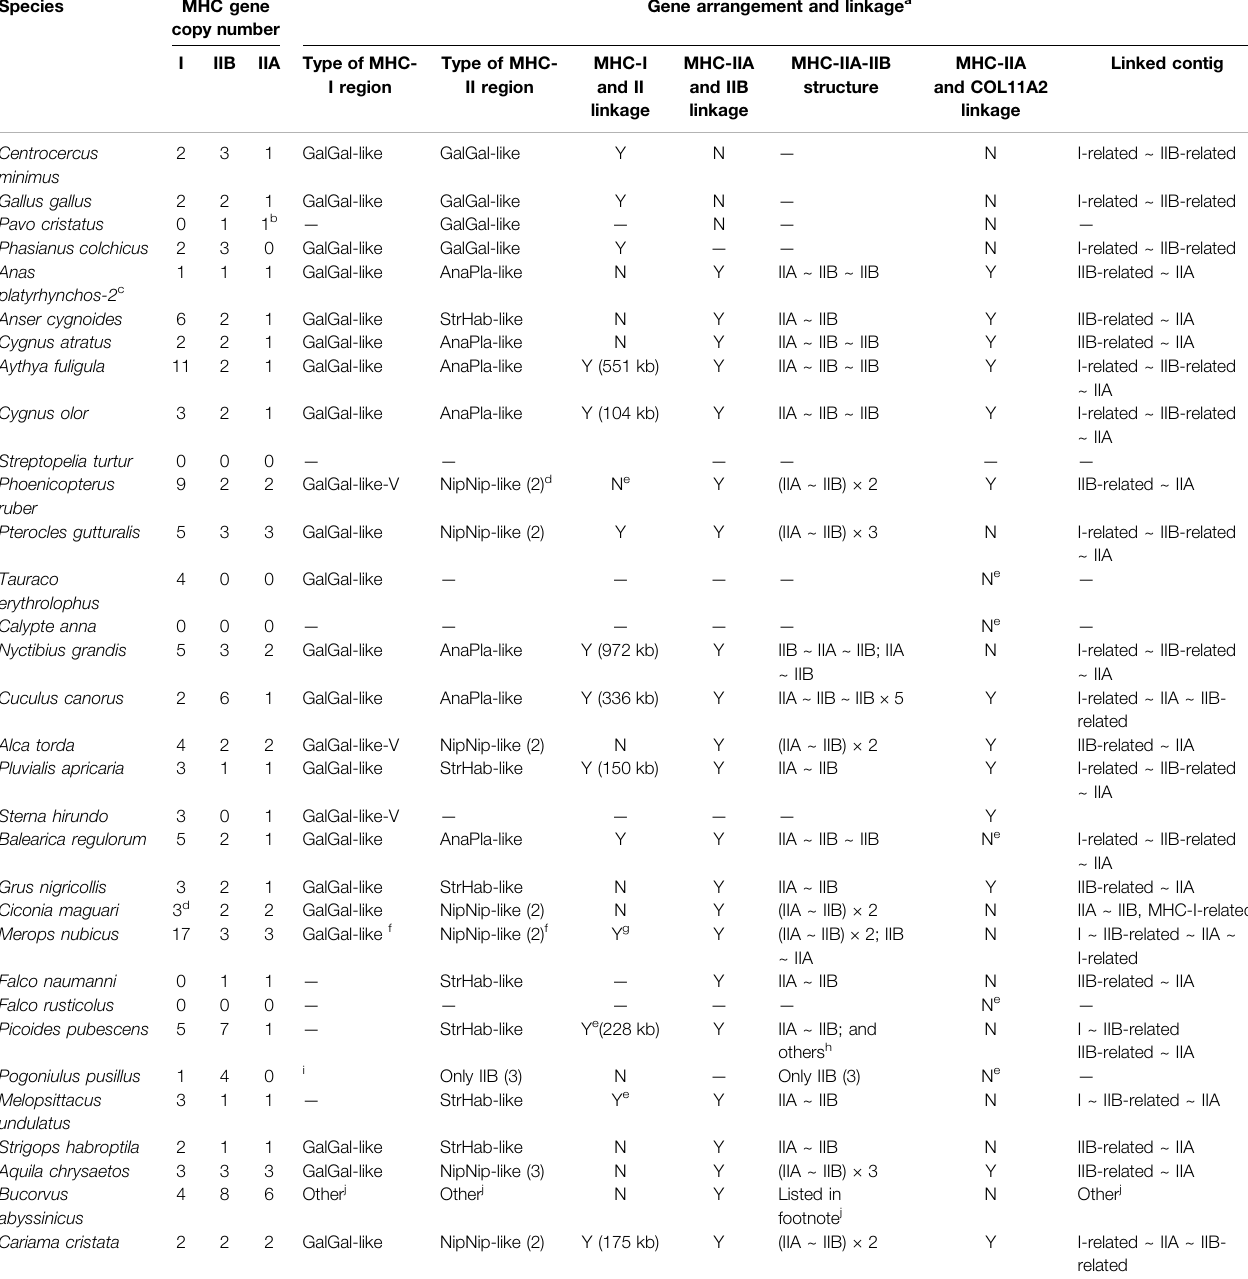
TABLE 1 | Gene numbers, linkage, and gene arrangement of MHC-I and MHC-II genes in non-passerine birds (TGS-based genomes).